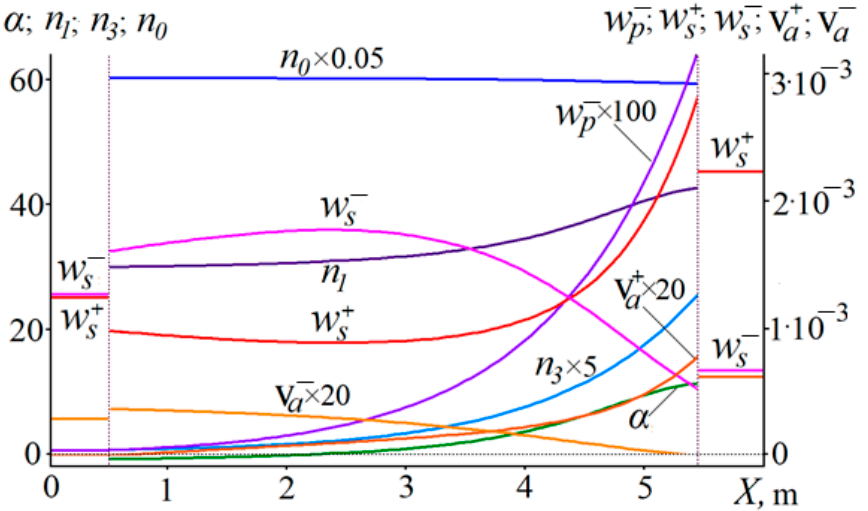
Figure 4. Spatial stationary distributions of the operating laser. Left scale: level populations n 0 , n 1 , n 3 and the gain coefficient α ; Right scale: the intensities of narrowband w + s , w − s and broadband v + a , v − a ASE waves, and the pump wave w − p intensity.